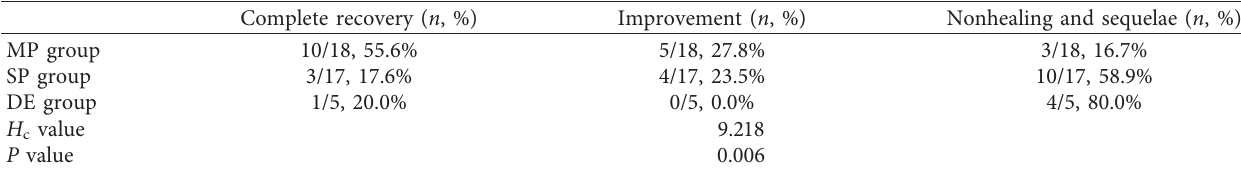
Table 7: Comparison of curative effect in the three groups after normal treatment (Kruskal–Wallis H test and Nemenyi